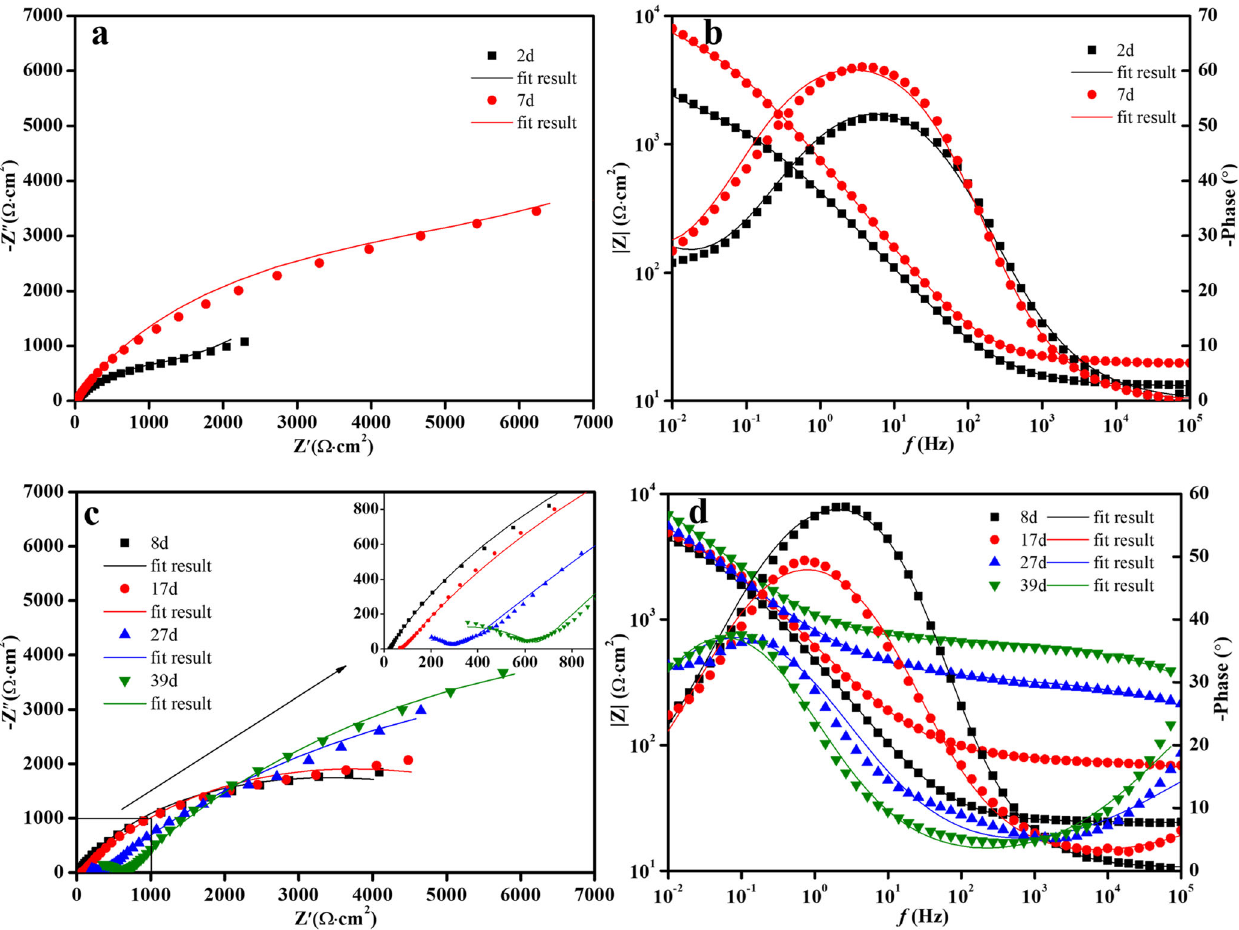
Fig. 6 EIS. Electrochemical impedance spectra of 3-1# (the fi rst electrode in row 3 in the full immersion zone) with respect to time: a , c Nyquist plots and b , d Bode